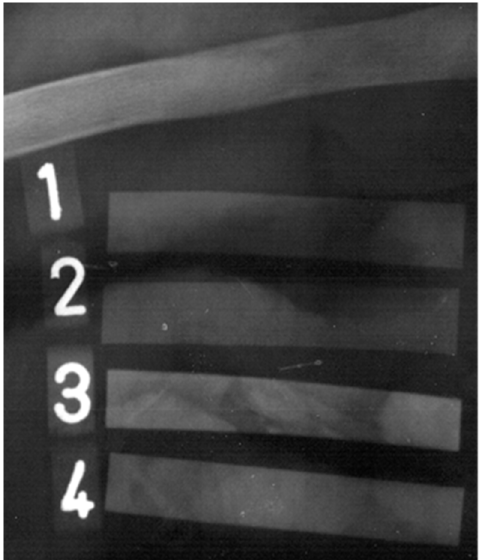
Figure 9. X-ray image of the radiopaque samples. The numbers 1, 2, 3, and 4 stand for the samples 10Bi, 17Ba, 20Bi, and 34Ba, respectively. In contrast, a bone is presented in the top part (above sample 10Bi).